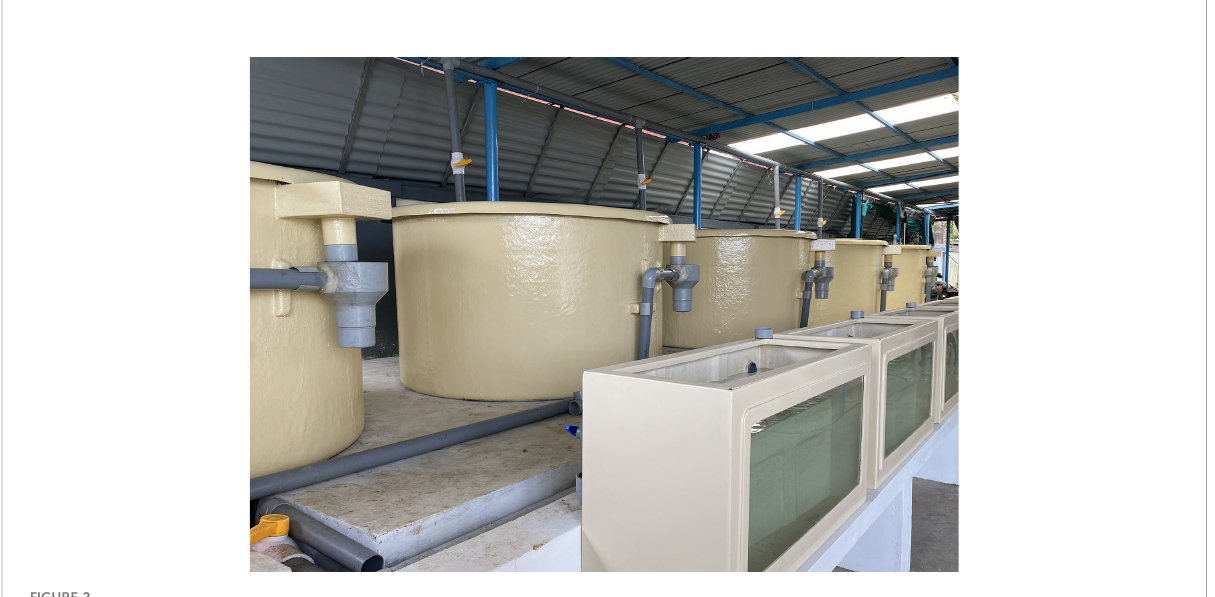
FIGURE 2 RAS units for Anthias broodstock rearing and